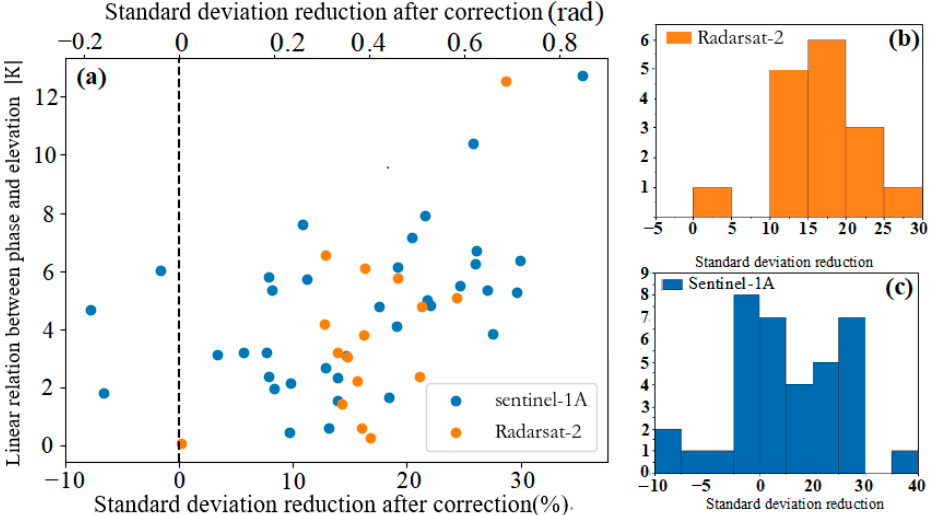
Figure 8. ( a ) Variation in the phase STD with |K|; ( b – c ) frequency distribution of STD variation for 17 interferograms from Radarsat-2 and 36 interferograms from Sentinel-1A, respectively, after atmospheric correction.